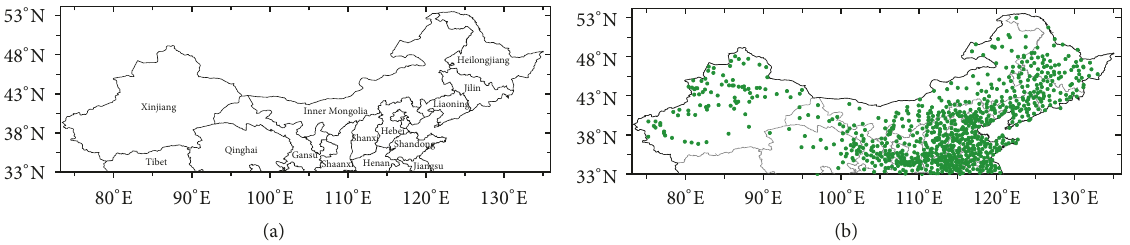
Figure 1: The administrative division (a) and spatial distribution of selected meteorological stations (b) in northern